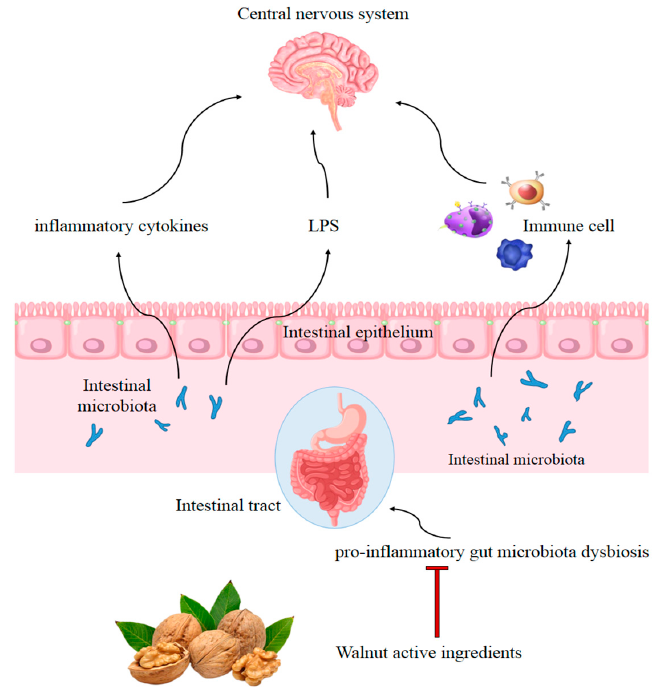
Figure 2. Possible mechanism of walnut consumption preventing inflammation in the CNS by remodeling disordered gut microflora. Adapted from